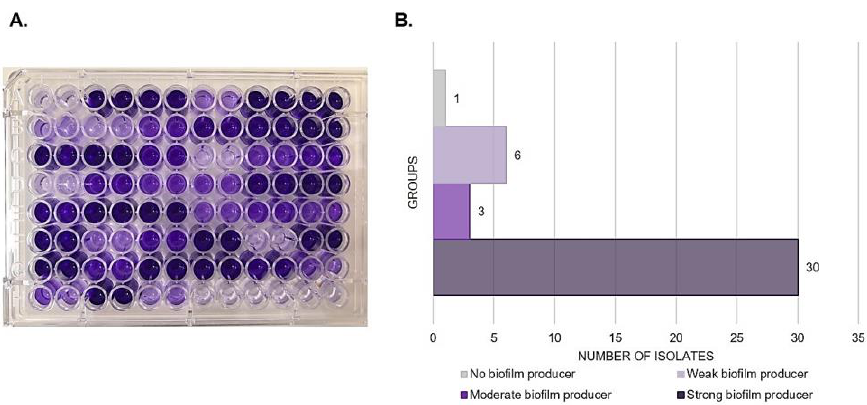
Figure 1. Distribution of C. parapsilosis complex in relation to the total of clinical isolates from IC cases per year of the study (August 2016 to August 2021).